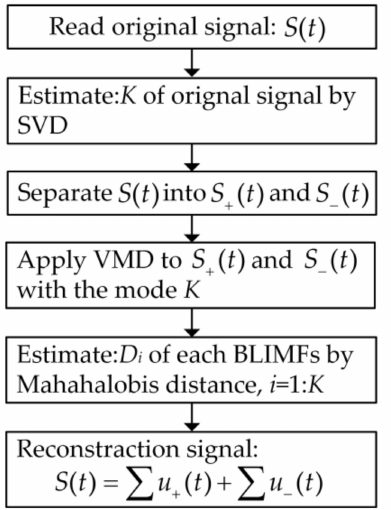
Figure 3. The flowchart of the adaptive CVMD algorithm.